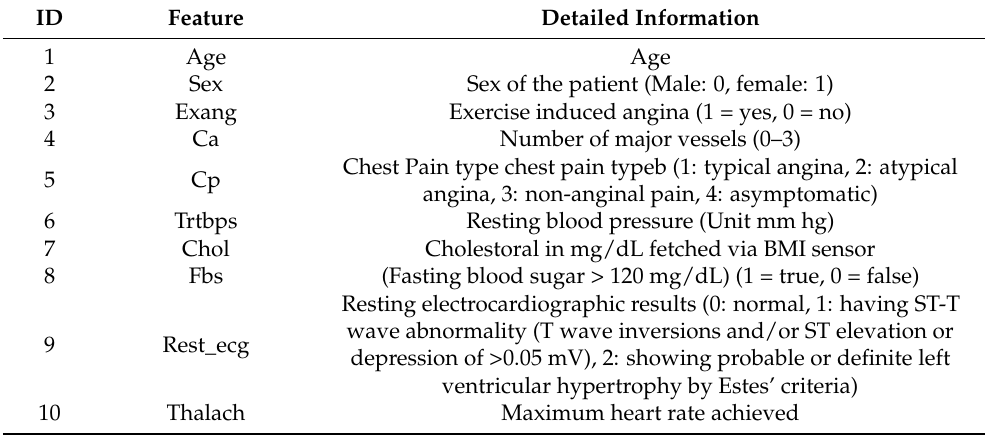
Table 2. Heart Attack